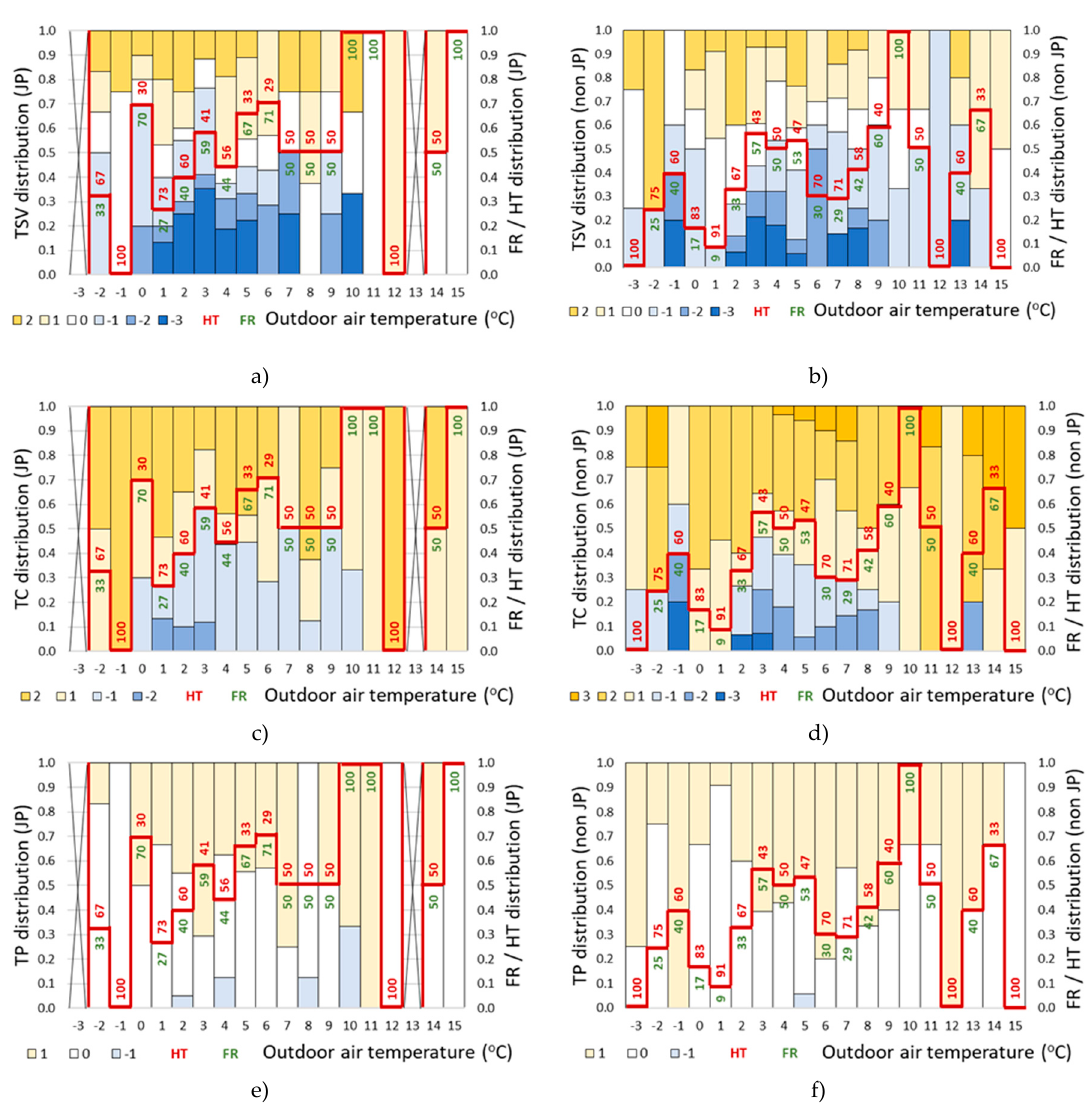
Figure 7. Frequency distributions of thermal responses relative to outdoor temperature and the use of air-conditioning; ( a ) Japanese TSV: Tout; ( b ) Non-Japanese TSV: Tout; ( c ) Japanese TC: